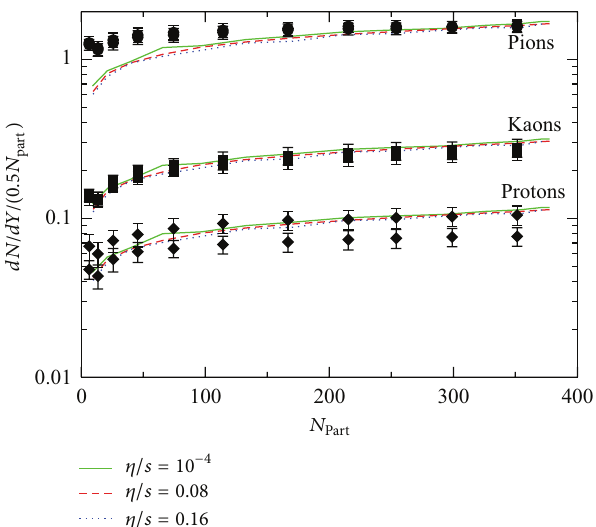
Figure7:Centralitydependenceofparticle’smultiplicityina2 + 1D hydrodynamical simulation is compared with experimental data. The figure is from [47].